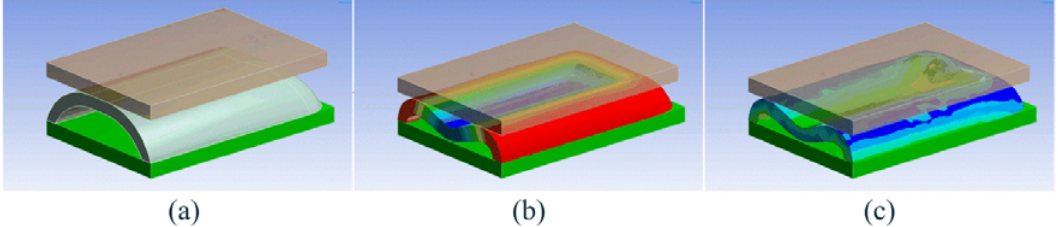
Figure 3. Finite element simulation of PSP1.1: ( a ) un-deformed structure; the rigid flat indenter is transparent brown, the silicone structure is grey and the PCB is green; ( b ) total deformation representation; ( c ) total stress representation (adapted from